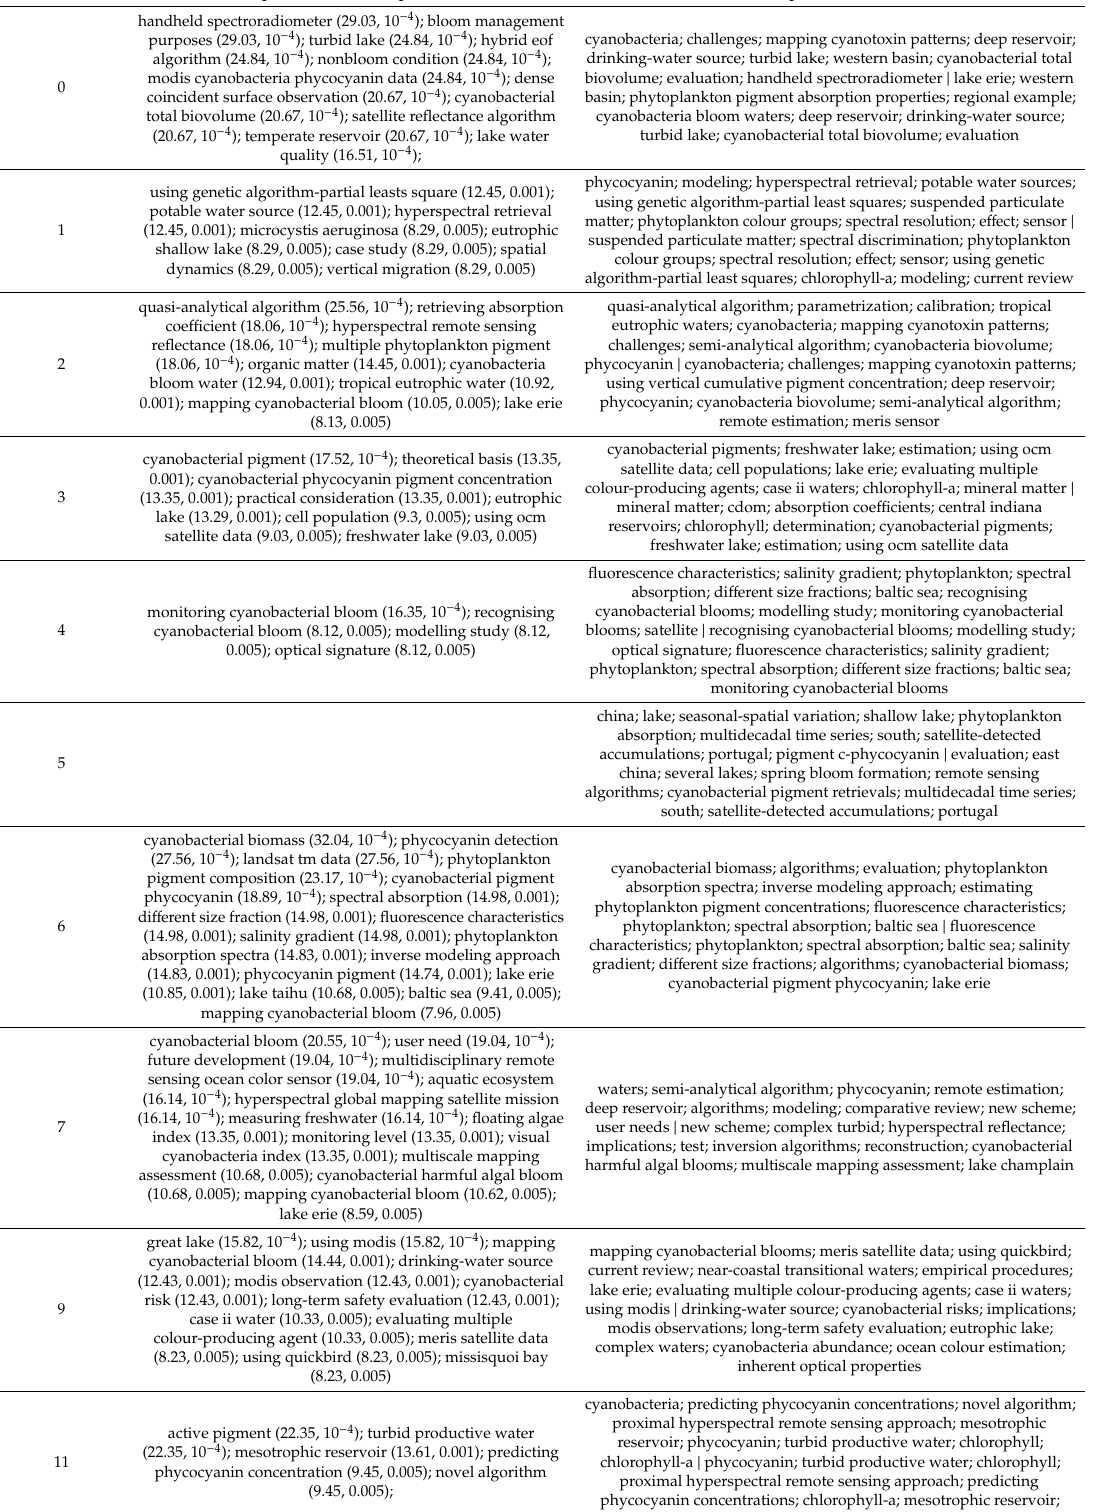
Table A2. Most relevant labels extracted by LSI and LLR